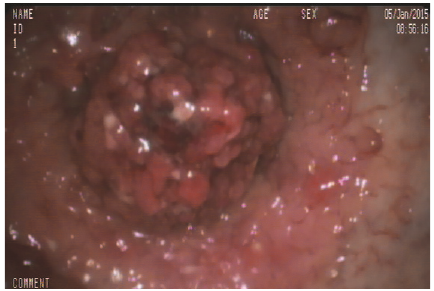
Figure 6: GIP of the transverse colon.